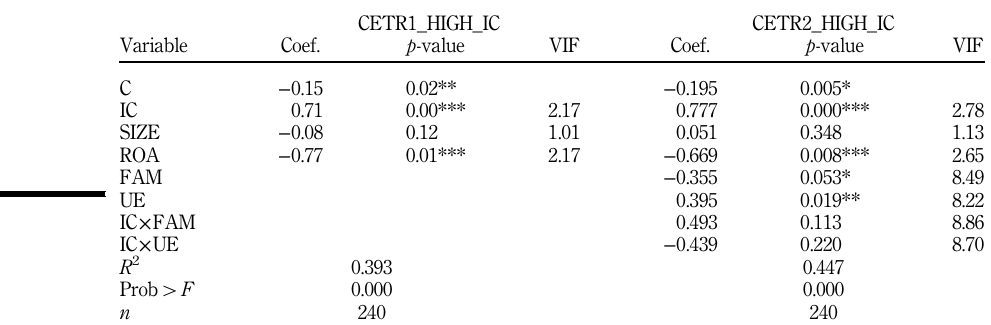
Table III. Additional testing based on internal control effectiveness